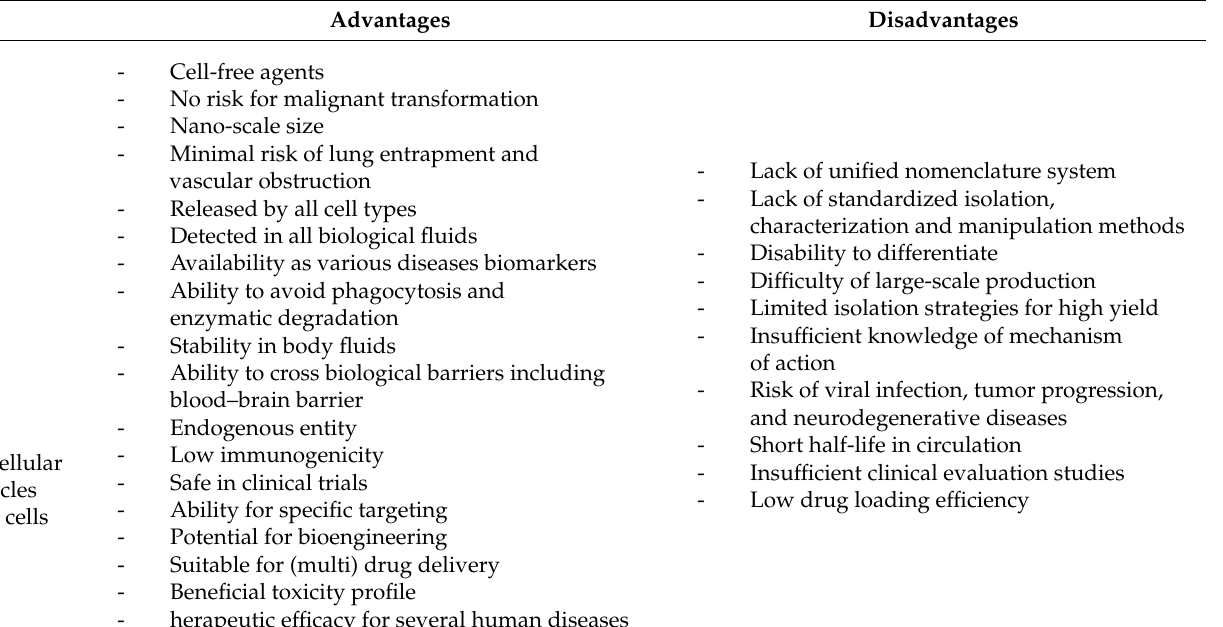
Table 1. Advantages and disadvantages of EV-based therapeutics, stem cell therapies and syn- thetic